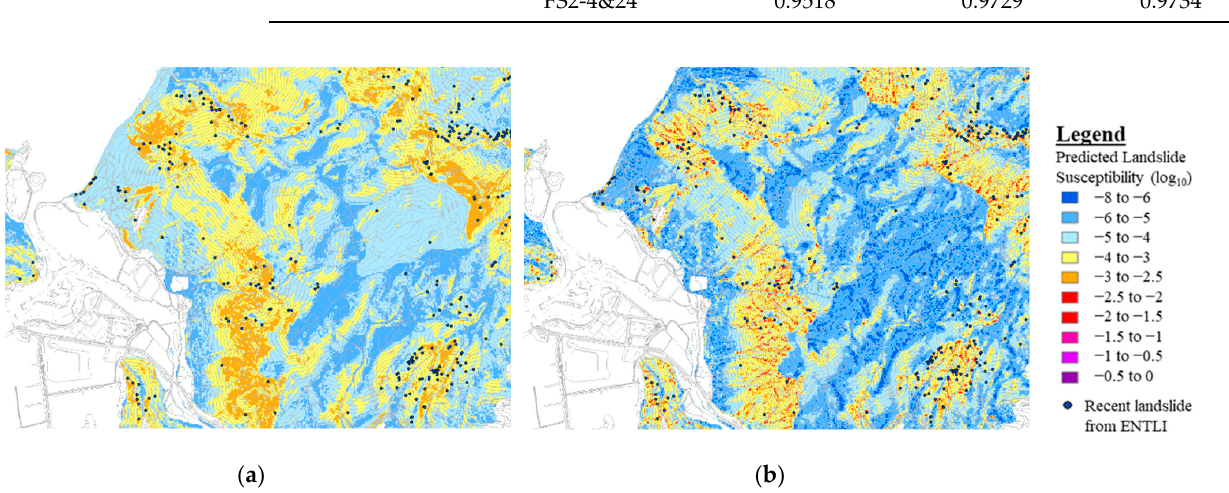
Figure 10. Predicted Landslide Susceptibility of the Tai O Area: ( a ) Model FS1-24-XGB under 24-h-NMRR of 0.225; ( b ) Model FS2-24-XGB under 24-h-NMRR of 0.225. Legend covers the range of landside susceptibility predicted for the entire pilot study